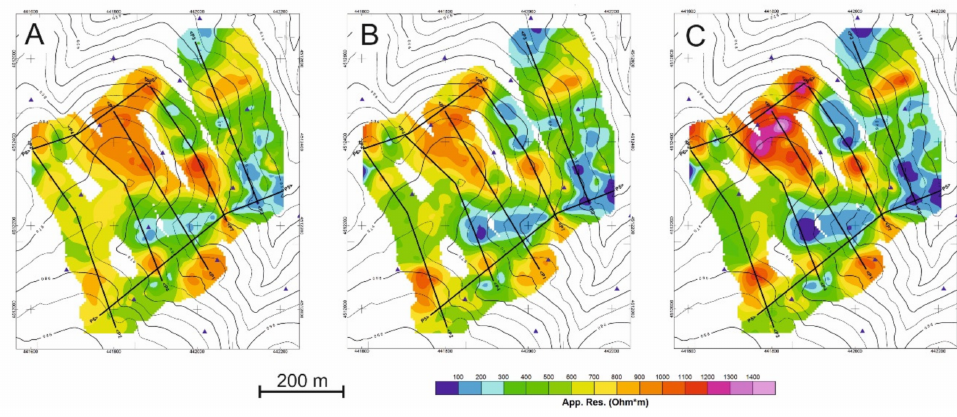
Figure 7. Apparent resistivity ( ρ ap) maps obtained at ( A ) 1.1 m depth, ( B ) 2.2 m depth, and